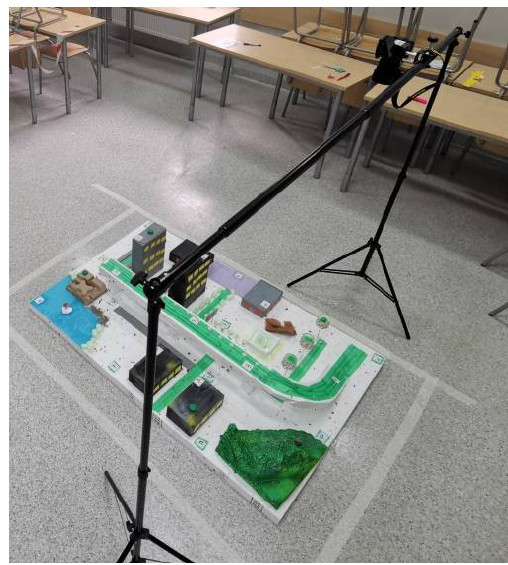
Figure 6. Mock-up and tripod with camera.